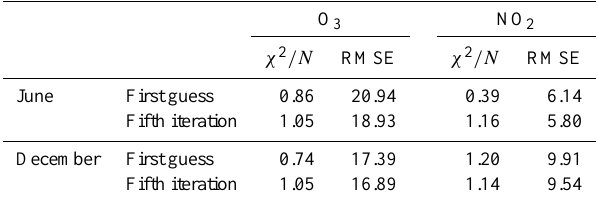
Table 2. The χ 2 /N consistency indicator and RMSE on rural MACC validation stations during the first and fifth iterations for tuning the observation and background error standard